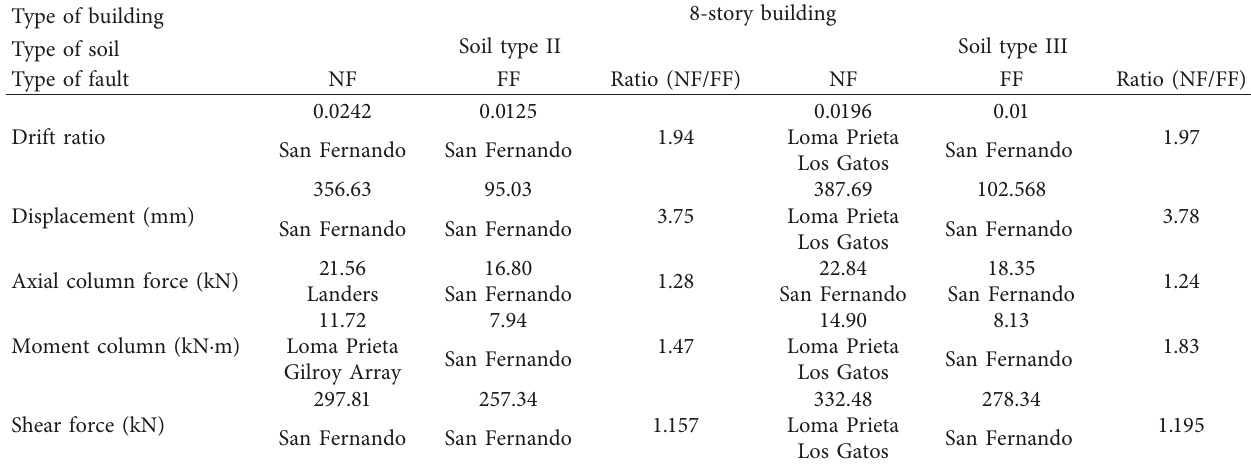
Table 16: A comparison of the maximum drift ratio, displacement, base shear, and moment of columns due to near-field earthquakes with progressive direction-taking and in far-field